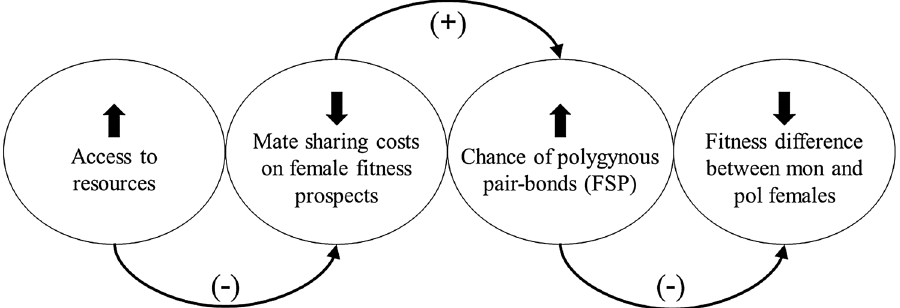
Figure 1. A schematic diagram of the EPT hypothesis. When there is easy access to the resources for rearing offspring, the expected costs of mate sharing on polygamous females’ fitness are negligible. Females are more willing to accept an already-mated male in these circumstances, increasing the frequency of social polygyny (FSP) in the population. The fitness difference, measured in this study as survival after the breeding season, between monogamous (mon) and polygamous (pol) females narrows or even